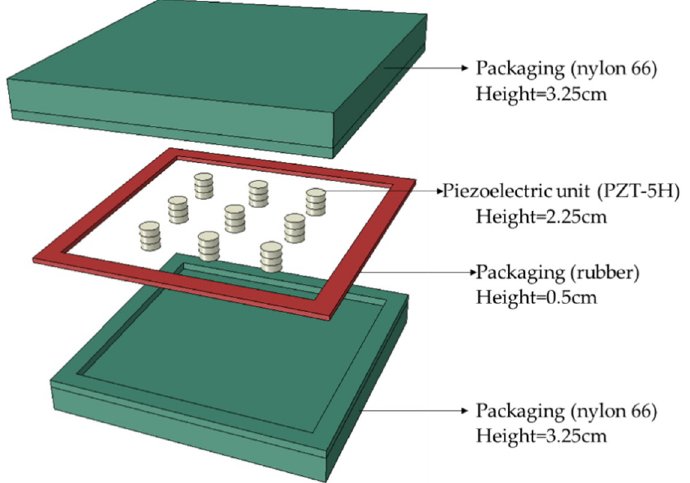
Figure 6. Overview of a PEH finite element model.